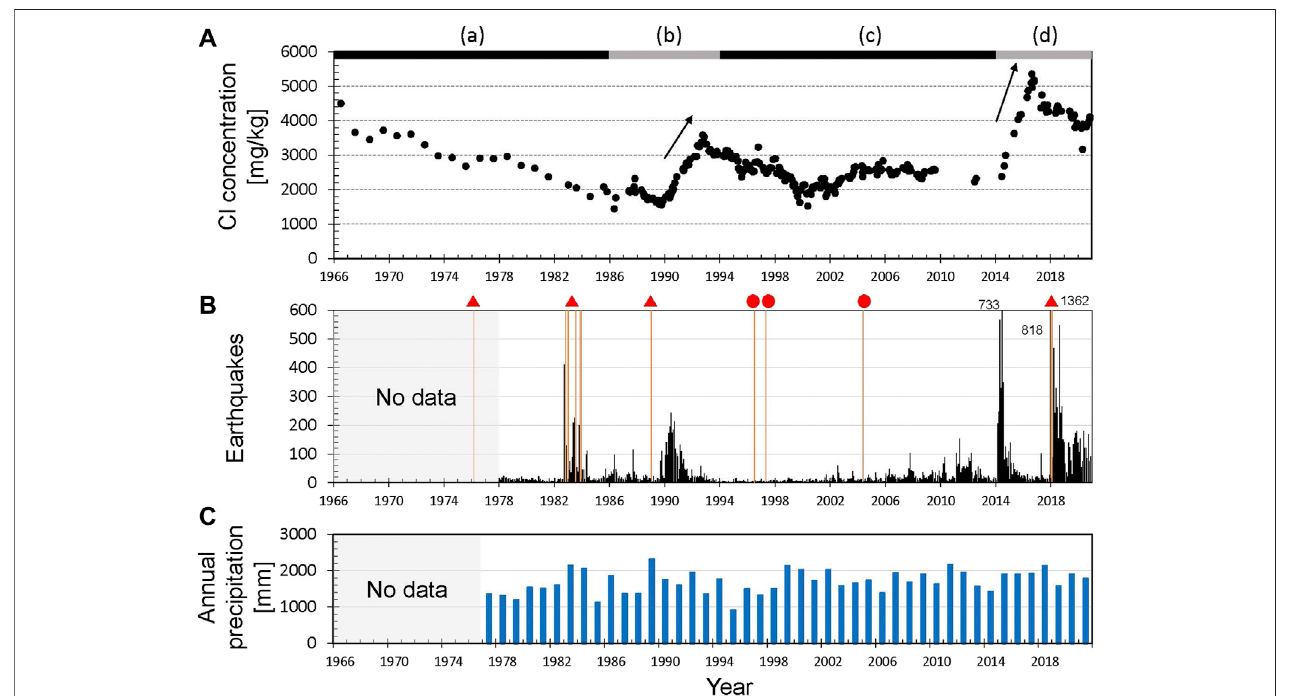
FIGURE 4 | (A) Cl concentrations of Yugama crater lake. (a – d) represent the periods de fi ned in estimations of C i eq . (B) Monthly numbers of earthquakes with maximum amplitudes of > 0.05 μ m and S – P times of < 2 s measured by the UD component at a seismic station that is 1 km northeast of Yugama crater lake. Triangles indicate the eruption at Kusatsu – Shirane volcano, and circles show lake water turbulence at Yugama crater lake, such as the appearance of a water dome. (C) Annual rainfall at Kusatsu town, which is 6 km east of Yugama crater lake. The data in (B) and (C) were provided by the JMA.